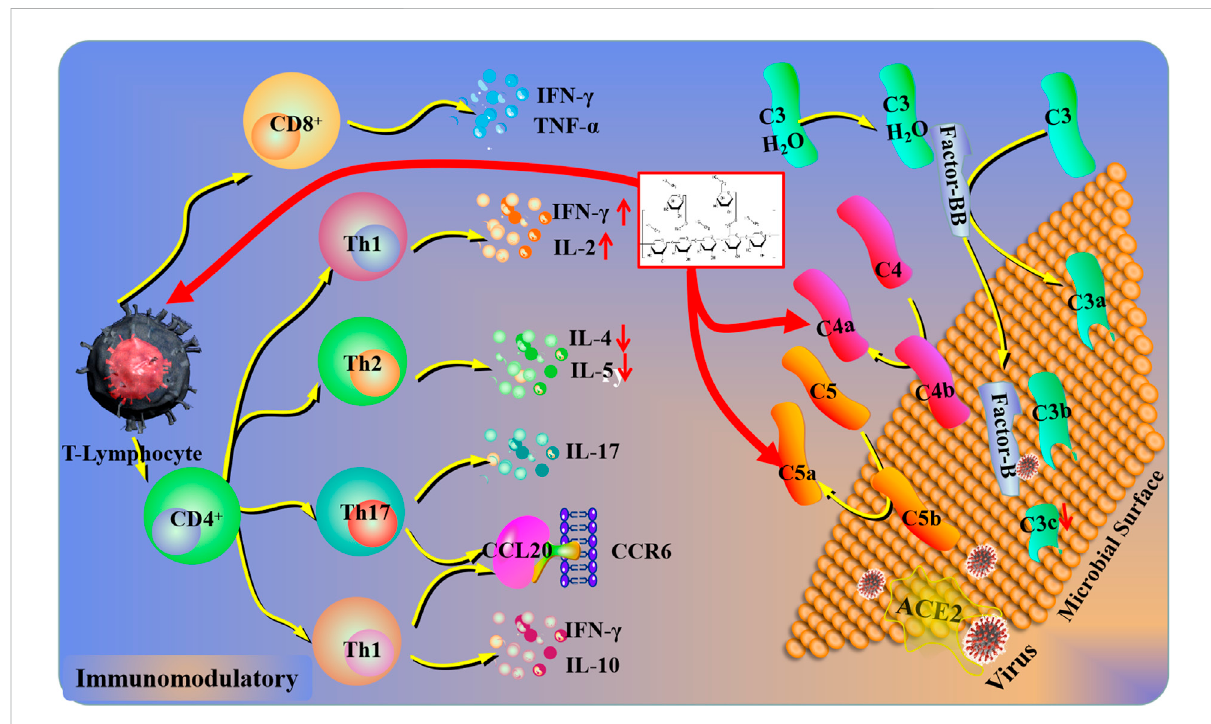
FIGURE 4 Immunomodulatory mechanisms of plant polysaccharides against lung injury. COVID-19 induces a pulmonary immune response via ACE2 (Angiotensin-converting enzyme II) receptor-mediated endocytosis into the airway epithelium. In response to COVID-19, the complement system inlungepithelialcellscouldbeactivated,whichwasdrivenbythetranscriptionoffactorBandC3a.PlantpolysaccharidescanaffectthelevelsofC5a, C4a, and C3b. In addition, the lymphocyte activation could be inhibited by plant polysaccharides via the complement